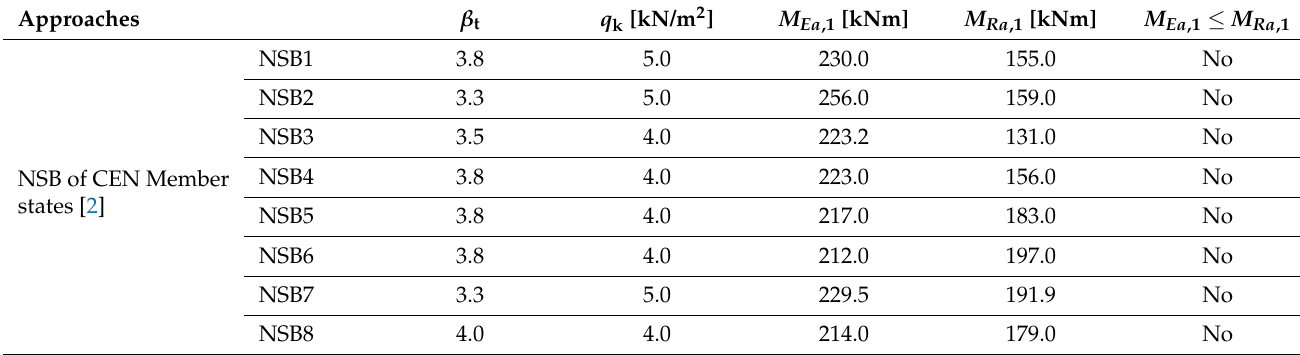
Table 6. First stage target reliability indices, characteristic values for imposed loads and assessment values for bending moment and